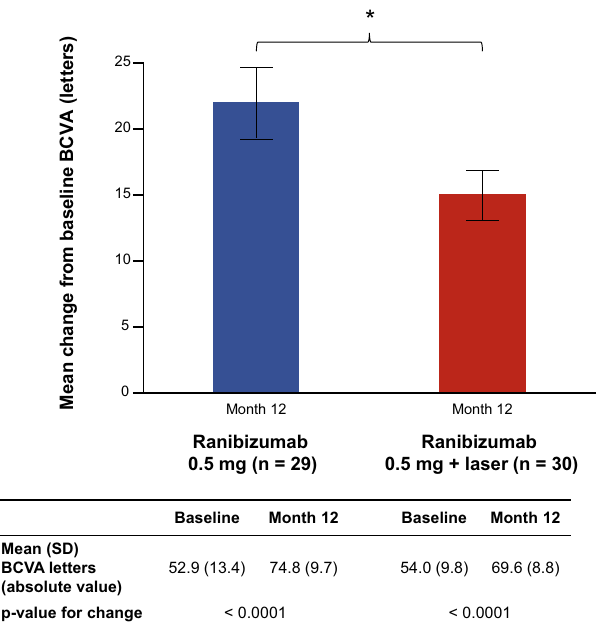
Figure 3. Mean change from baseline in BCVA letter score in the study eye at Month 12 (full analysis set, LOCF). BCVA best corrected visual acuity, LOCF last observation carried forward, SD standard deviation. *p < 0.05.